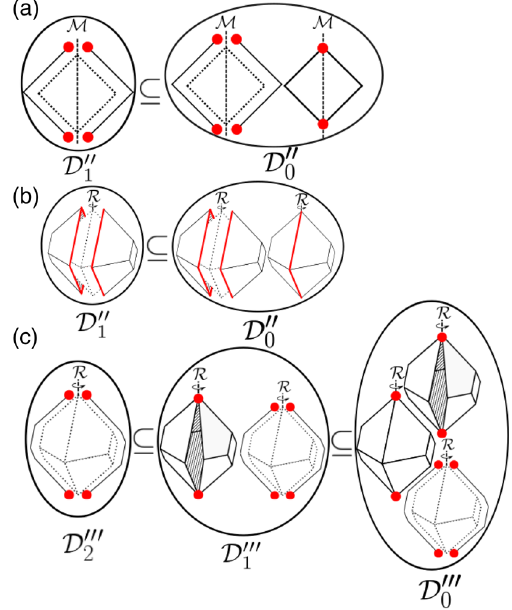
FIG. 5. Examples of the subgroup sequence (22) for the decoration subgroups D ð n Þ and the extrinsic boundary classifying k group D ð n Þ 0 . (a) For a two-dimensional crystal with mirror symmetry, the group D 00 0 classifies all possible configurations of corner states on the mirror axis, whereas the decoration subgroup D 00 1 classifies corner states on the mirror axis that can be obtained by “ gluing ” two mirror-related first-order topological phases to the crystal boundary. (b) For a three- dimensional crystal with twofold rotation symmetry, D 00 0 classifies all configurations of protected hinge modes along the intersection ∂ Ω Ω 2 of the reference manifold 2 and the crystal boundary, whereas the decoration subgroup D 00 1 classifies all protected hinge modes along ∂ Ω 2 that are obtained by gluing two rotation-related first-order topological phases to the crystal boundary. (c) For a three-dimensional crystal with twofold rotation symmetry, D 000 0 classifies all configurations of protected zero-energy states at the two corners on the rotation axis. The subgroups D 000 2 and D 000 1 contain corner states on the rotation axis that are obtained from decorating rotation-related hinges or surfaces with first-order and second-order topological phases,